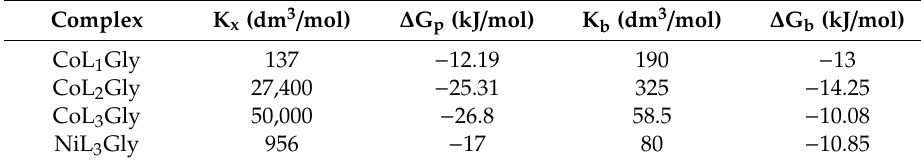
Figure 3. Plots of simple and differential absorbance vs. SLS concentrations. Table 6. Partitioning and binding parameters of selected complexes in micellar